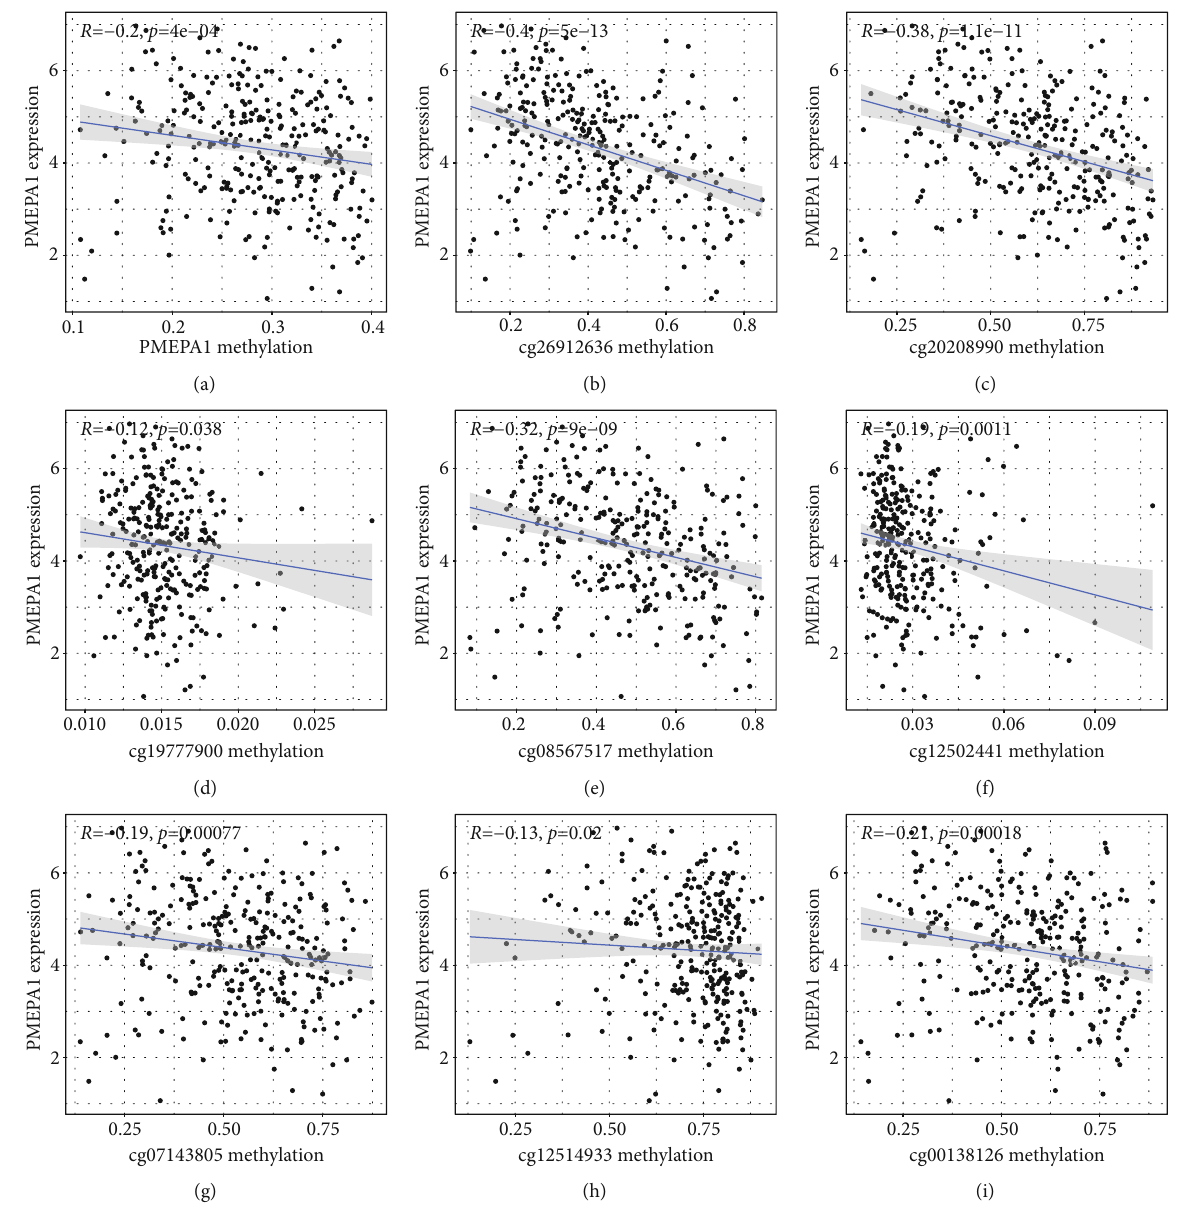
Figure 3: Correlation analysis of PMEPA1 mRNA expression with DNA methylation. (a) The expression of PMEPA1 was negatively regulated by PMEPA1 DNA methylation. (b) – (i) Correlation analysis of PMEPA1 mRNA with the methylation of (b) cg26912636, (c) cg20208990, (d) cg19777900, (e) cg08567517, (f) cg12502441, (g) cg07143805, (h) cg12514933, and (i)